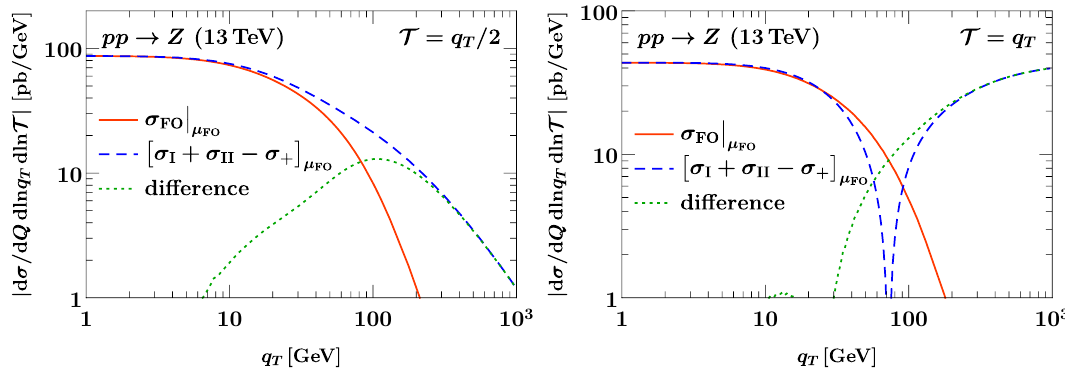
Figure 9 . Singular/nonsingular comparison between the matched SCET descriptions and QCD at (cid:12)xed O ( (cid:11) s ) as a function of q T for T = q T = 2 (left) and T = q T (right). The orange solid line shows the (cid:12)xed-order QCD double spectrum, the dashed blue the matched SCET result in eq. (3.4), and the dotted green the